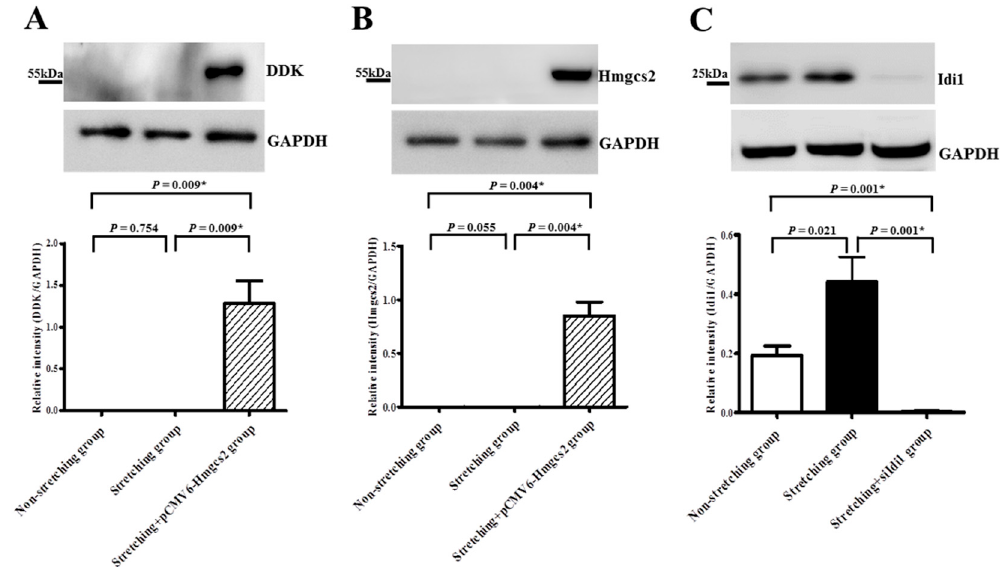
Figure 7. Immunoblot results for DDK ( A ), Hmgcs2 ( B ), and Idi1 ( C ) proteins in the non-stretched group, stretched group, and stretched group with plasmid transfection of pCMV6- Hmgcs2 (Myc-DDK-tagged) ( A , B ), and the stretched group with RNA interference of Idi1 ( C ). Plasmid transfection of pCMV6- Hmgcs2 (Myc-DDK-tagged) in stretched HL-1 atrial myocytes was confirmed by significantly increased expressions of DDK ( A ) and Hmgcs2 ( B ) in stretched HL-1 atrial myocytes that received plasmid transfection. Silencing of Idi1 in stretched HL-1 atrial myocytes was confirmed by significantly decreased expression of Idi1 ( C ) in stretched HL-1 atrial myocytes that had received RNA interference. * p < 0.05.